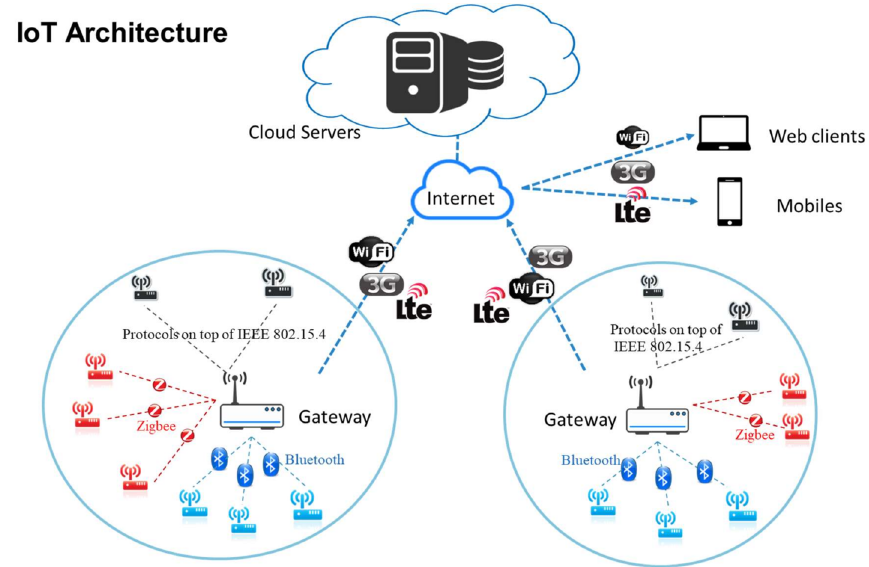
Figure 1. The generic architecture of the Internet of